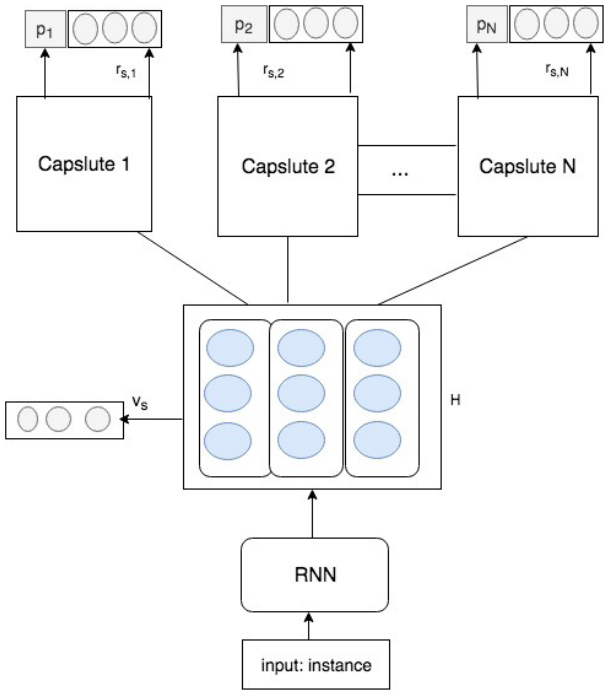
Fig. 5. The RNN-Capsule for sentiment classi¯cation.